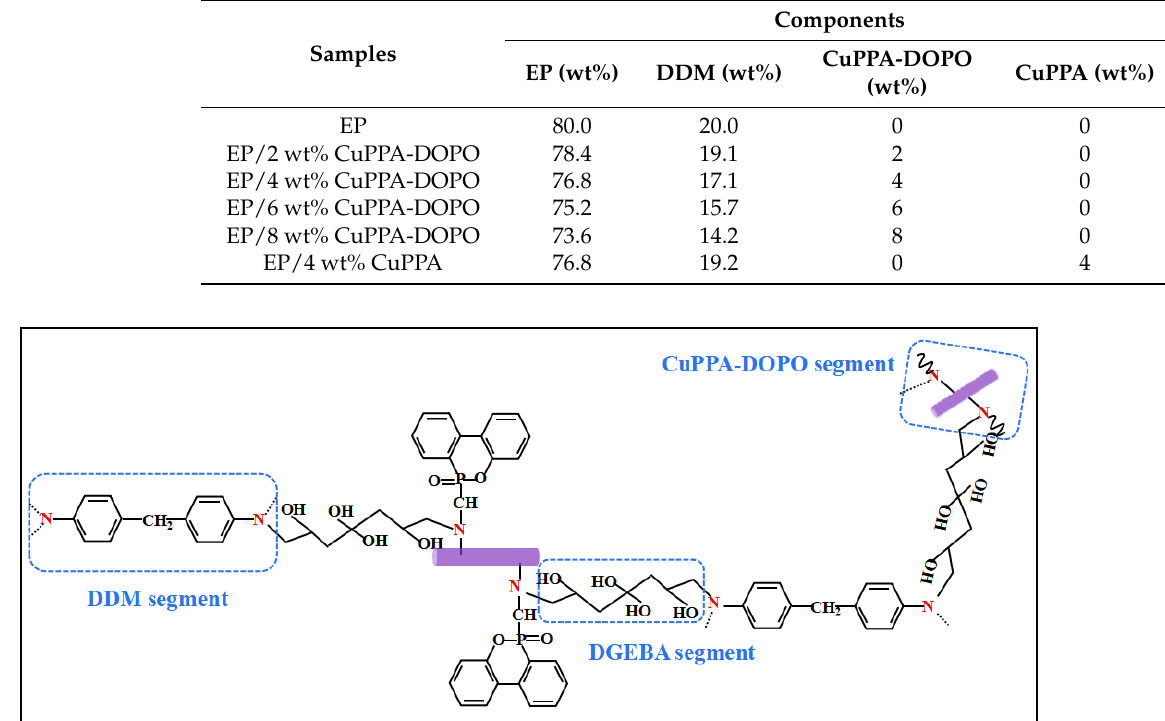
Figure 9. Schematic diagram of the curing reaction of EP composites.